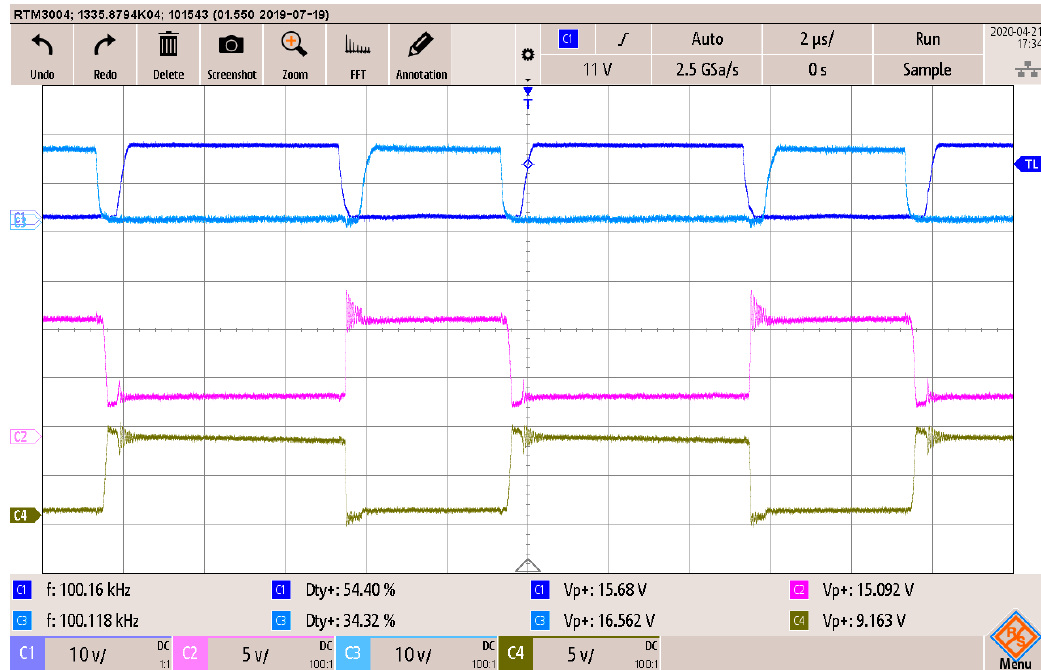
Figure 19. Waveforms of switch V GS and V DS with 10 V of input and 12 V/1 A of output (CH1, V GS 1 ; CH2, V DS 1 ; CH3, V GS 2 ; CH4, V DS 2 ).